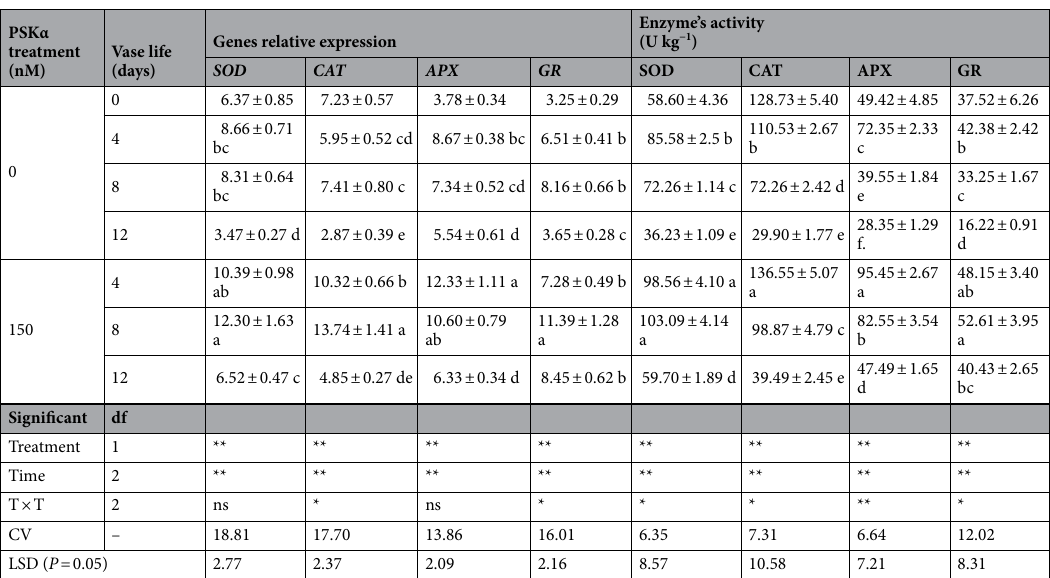
Table 5. SOD , CAT , APX and GR genes expression and enzymes activity in petals of rose flowers treated with PSKα at 0 and 150 nM during vase life at 20 °C for 12 days. Data shown are mean values of n = 3, and the error bars represent standard errors of the means. Mean values followed by different letters indicate they are different by LSD test at P < 0.05.